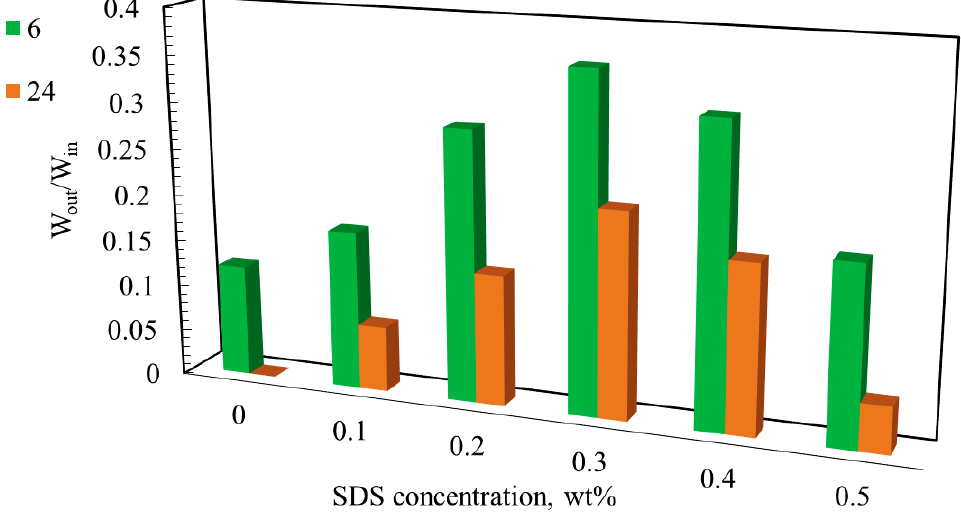
Figure 5. Effect of surfactant addition on silica NP agglomeration and retention (Test temperature: 40 °C; flow rate of injection: 1 mL/min; concentration: 0.5 wt%).